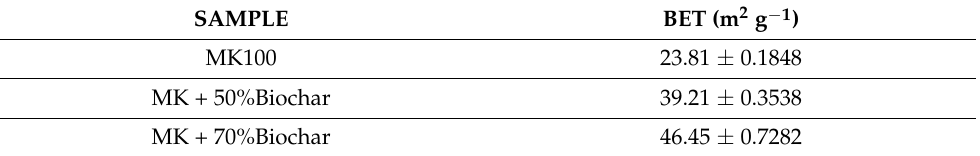
Table 4. BET of MK100%, MK + 50%Biochar and MK + 70%Biochar samples at 90 curing